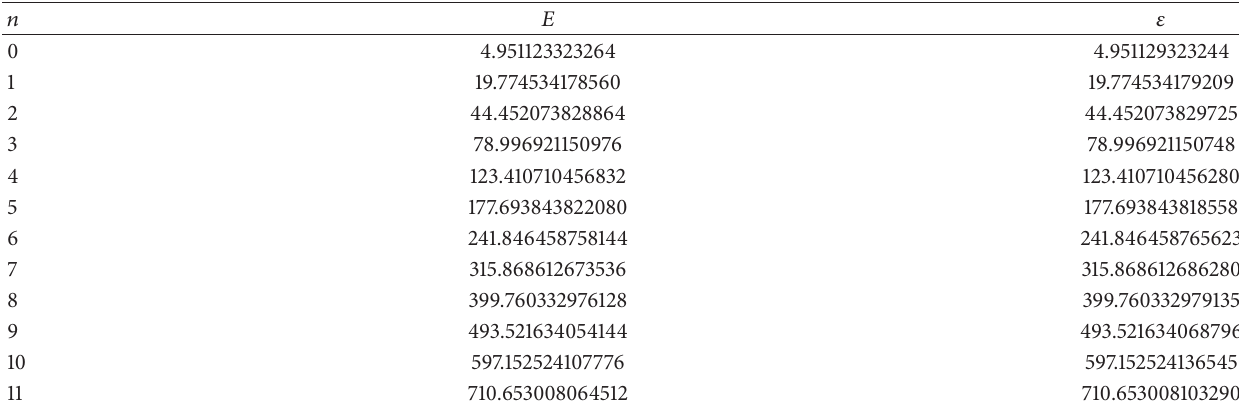
Table 6: Approximation of the energy levels of the harmonic oscillator 𝐻 = −(1/2)Δ + (1/2)𝑥 2 in dimension 𝑑 = 1 . For the state 𝑛 , 𝐸 𝑛 is a highly accurate solution for the energy provided by Aguilera-Navarro et al. [2], 𝜀 𝑛 is the upper bound for 𝐸 𝑛 obtained using the present variational analysis with basis size 𝑁 = 250 , and 𝐿 = 0.5 . This table shows the energies of the first 12 states 𝑛 = 0,1, .. . ,11 . 𝑛 𝐸 𝜀